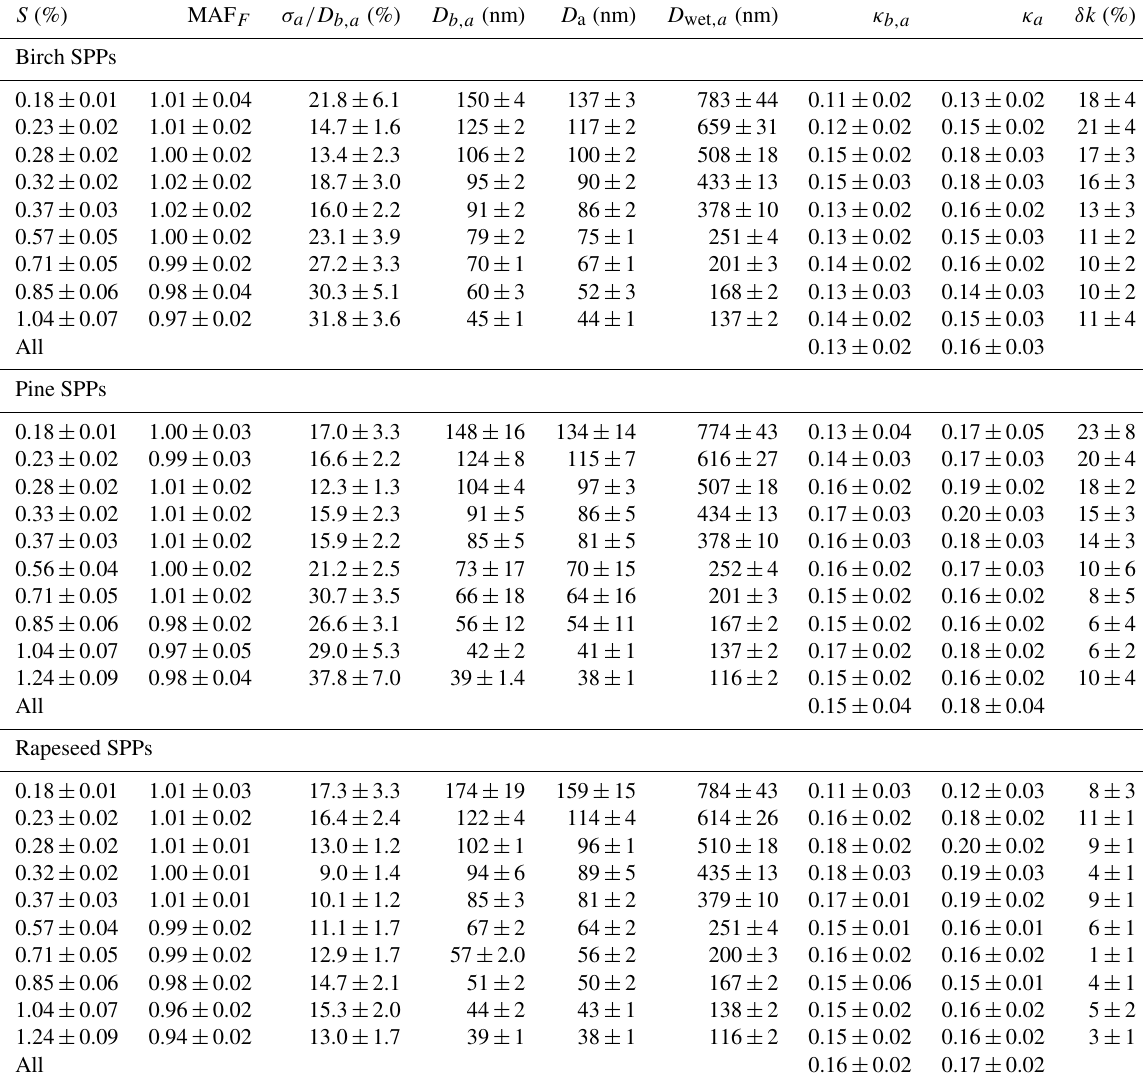
Table 3. Characteristic average CCN parameters (mean values ± SD) for subpollen particles (SPPs) at different S (%) values obtained in a series of three measurements for each sample. Quantities are a maximum activated fraction, MAF F ; heterogeneity parameter, σ a /D b,a ; and initial ( D b,a and κ b,a ) and shape-corrected ( D a and κ a ) dry diameter and hygroscopicity parameter, respectively. δκ is the relative change in hygroscopicity due to particle restructuring, and D wet ,a is the wet activation diameter.